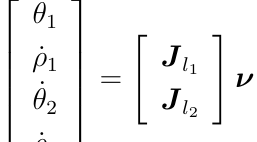
Figure 12. An example of the ( ρ - θ ) representation for two lines, (cid:96) . Signs of the two parameters, ρ and θ , are shown for the corresponding positive or negative quantities. is the principle point and origin of the pixel coordinate frame is at the top-left of the image plane by